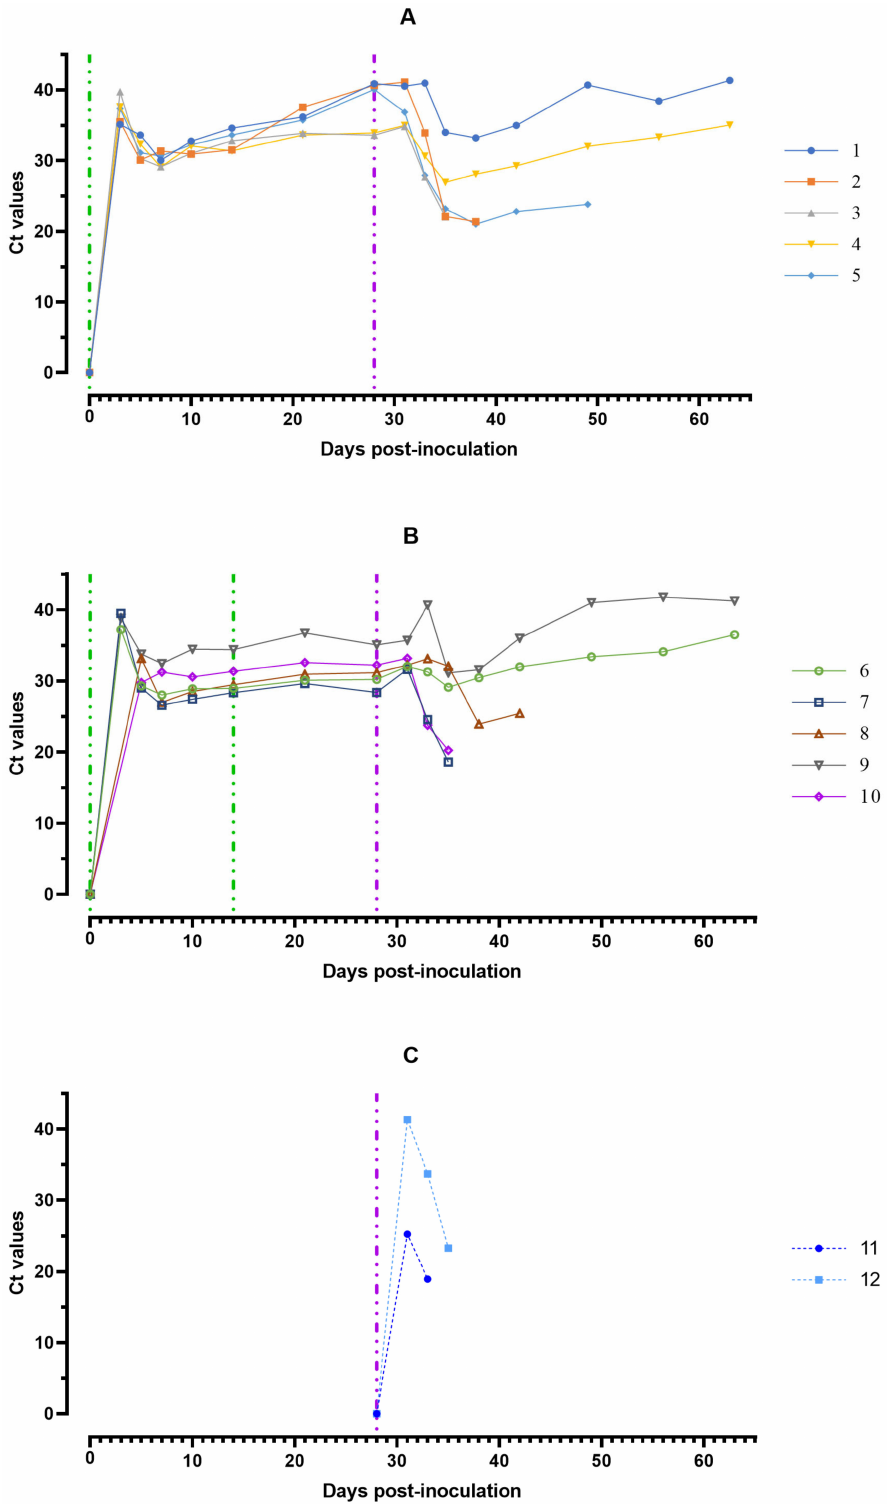
Figure 4. Values of ASFV-specific qPCR results of blood samples of pigs from 0 to 63 dpi: ( A ) group #1 after inoculation with the ASFV-Katanga-350 and challenge on the 28th day with the ASFV-Stavropol 01/08; ( B ) group #2 after two inoculations with the ASFV-Katanga-350 and challenge on the 28th day with the ASFV-Stavropol 01/08; ( C ) group #3 after challenge with the ASFV-Stavropol 01/08. Each bar represents an individual animal’s values. Vertical dashed lines: green—days of inoculation of ASFV-Katanga-350, purple—challenge by the ASFV–Stavropol 01/08. Results are displayed as